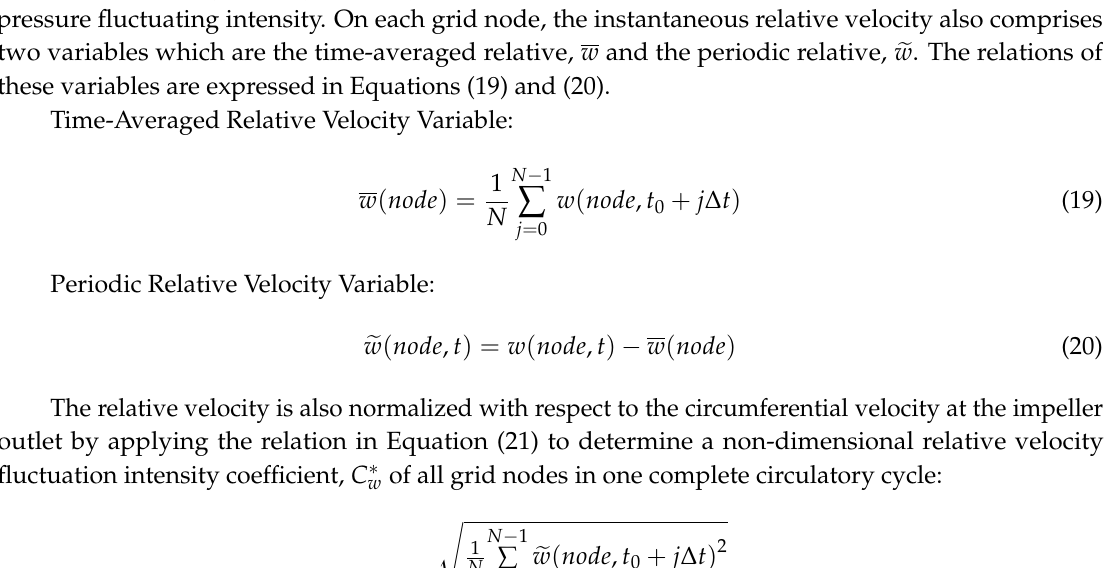
Figure 21. Frequency domain history of pressure fluctuation of the impeller and side channel passages for three pump cases.